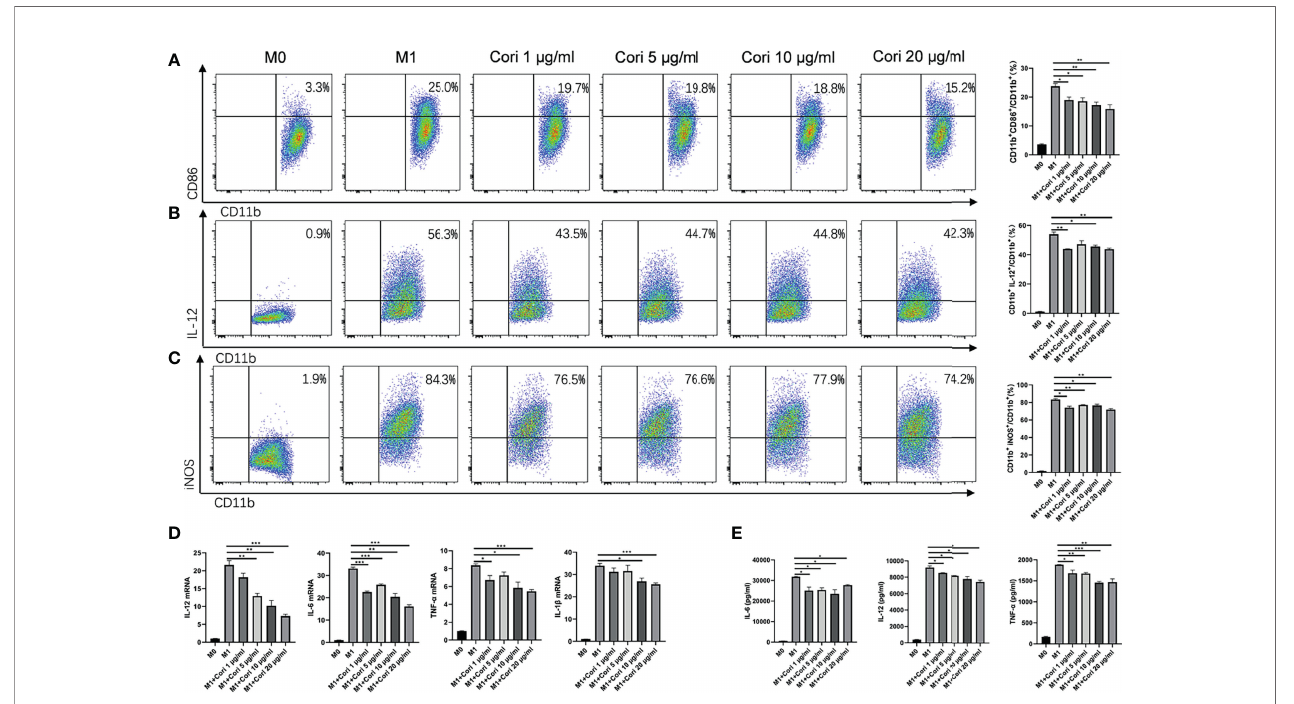
FIGURE 5 | Corilagin reduces the activation of M1 macrophages and inhibits in fl ammatory cytokine release in vitro . BMDMs were treated with corilagin (1, 5, 10, or 20 m g/ml) for 2 h, followed by stimulation with lipopolysaccharide (LPS) and interferon g (IFN- g ). After 24 h, the supernatant and cells were collected. (A) Proportion of CD86 + cells. (B) Proportion of IL-12 + cells. (C) Proportion of iNOS + cells. (D) mRNA levels of IL-12, IL-6, TNF- a , and IL-1 b . (E) Protein levels of IL-12, IL-6, and TNF- a in the cell culture supernatant. *p < 0.05, **p < 0.01, ***p <